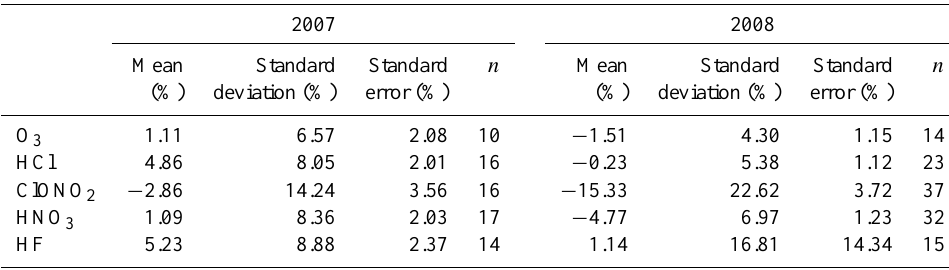
Fig. 9. As for Fig. 5, but with those comparison pairs remaining after tightened criteria have been applied. Note that the distances shown in this plot are now the distance between the measurements along the lines-of-sight at 18km, as described in the text. Table 4. As for Table 3, but for pairs remaining after applying rigorous co-location